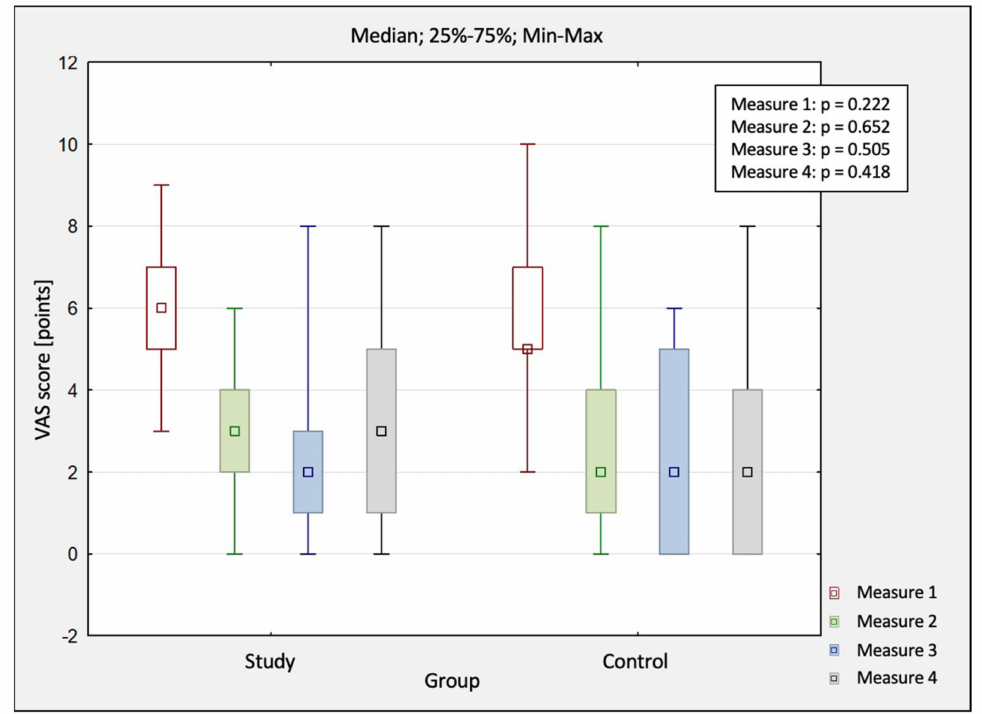
Figure 3. The comparison of changes in pain scores (VAS) between the study and control group. Abbreviations: M1, before treatment; M2, after treatment; M3, 1 month after study completion; M4, 3 months after study completion; VAS, Visual Analogue